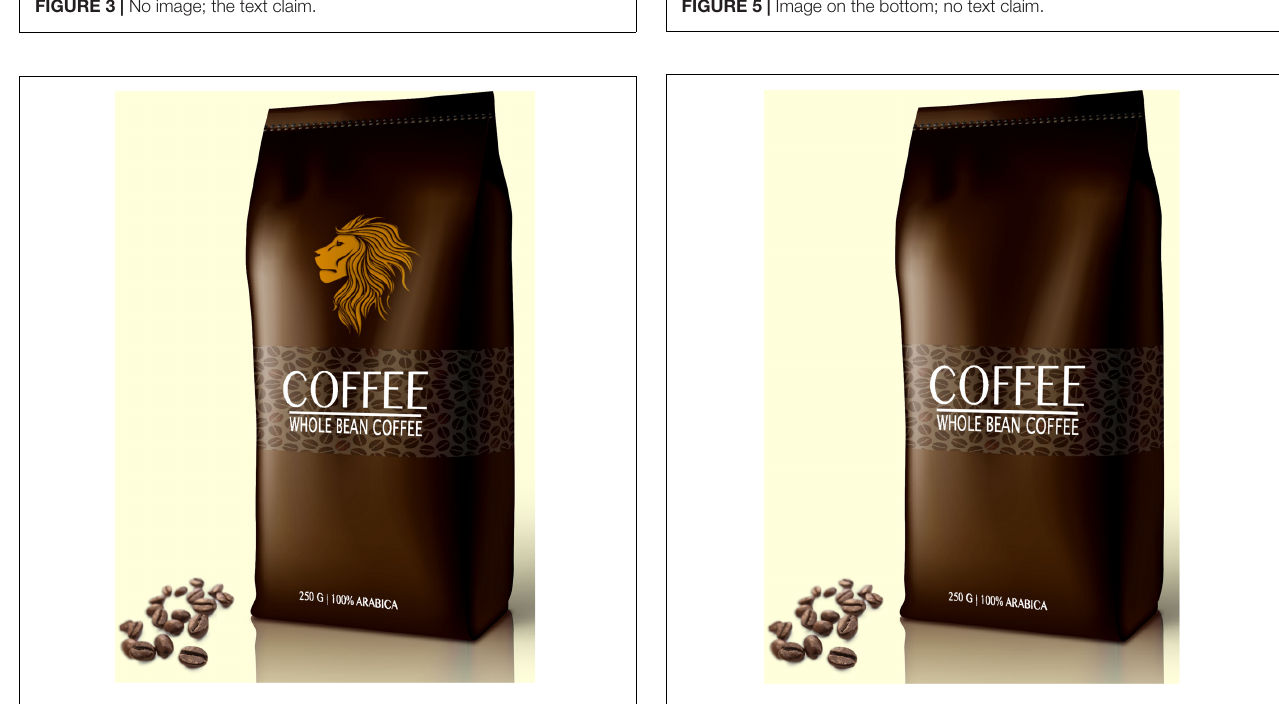
FIGURE 5 | Image on the bottom; no text claim.